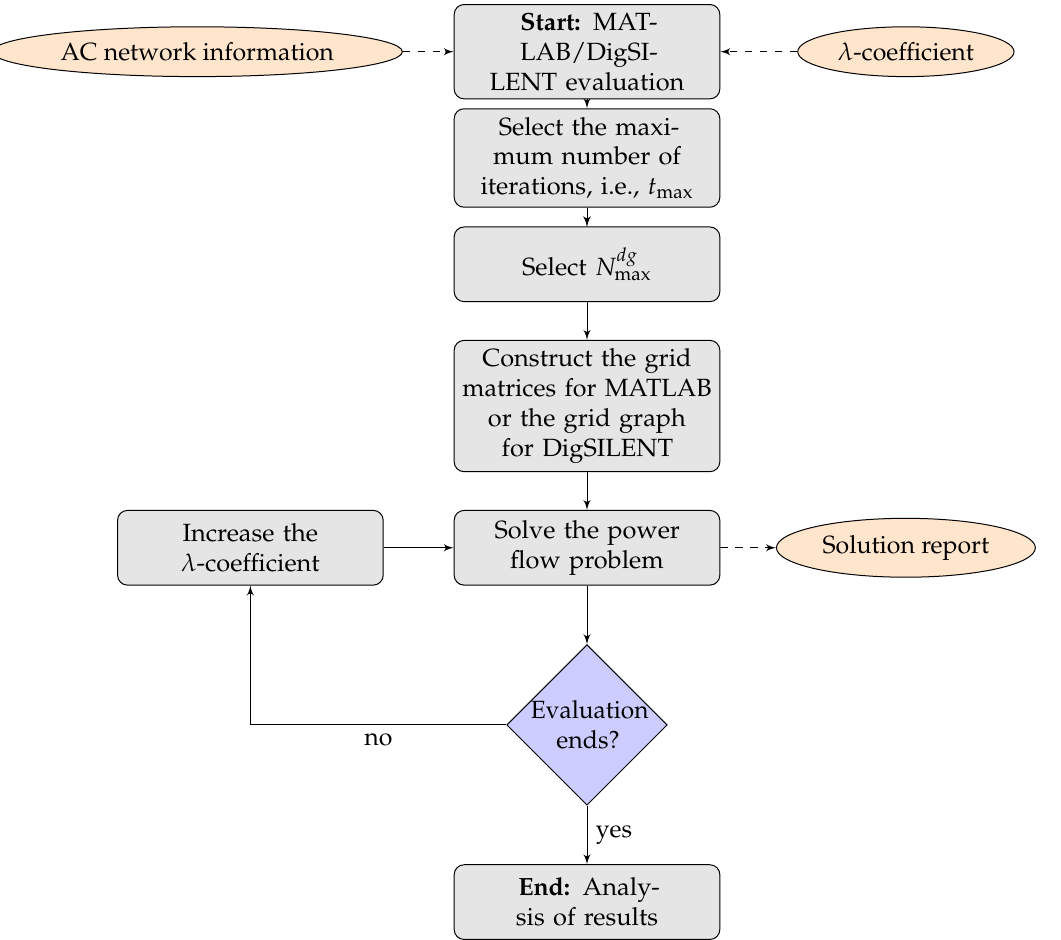
Figure 3. Recursive validation of the maximum loadability coefficient using MATLAB and